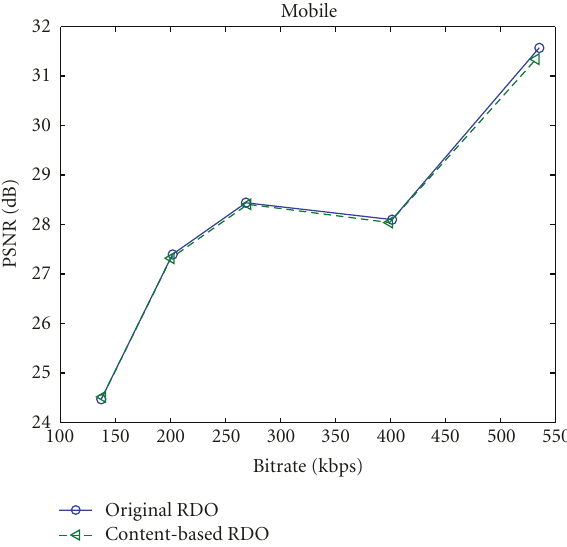
Figure 5: Comparison of PSNR results between the reference software and the proposed scheme for “Mobile.”